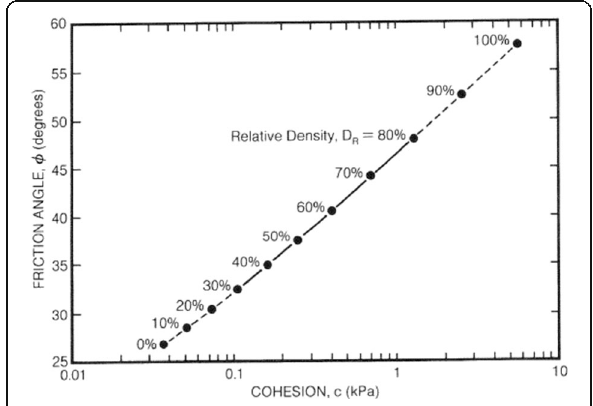
Fig. 14 Friction angle as a function of cohesion and relative density for the regolith on the Moon (same as Fig. 9.27 of Heiken et al. 1991)